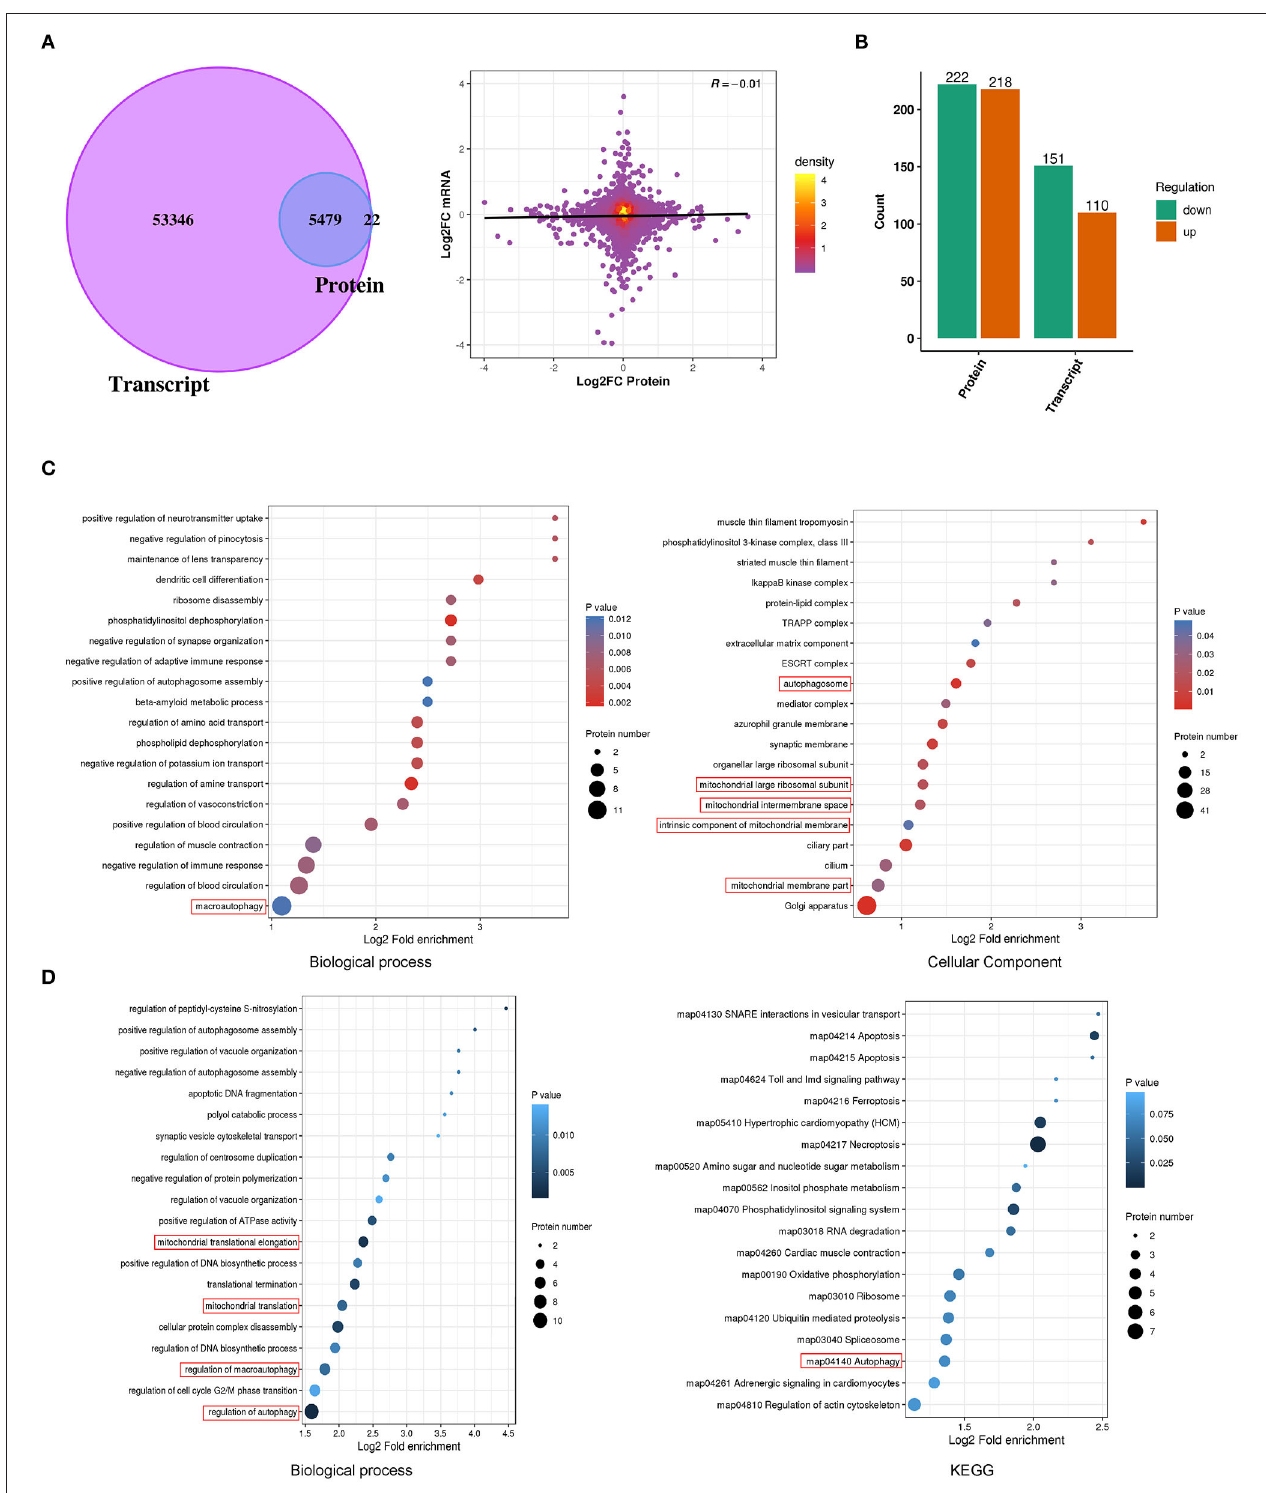
FIGURE 3 | Proteomic combined with transcriptomic analysis of E2-BSA treated Ishikawa cell line. (A) Venn diagram and volcano chart depicting the overlap of proteomic and transcriptomic relative genes. (B) The distribution of genes up- and down-regulated in protein and transcript, respectively. (C) Results of GO and KEGG analysis of the up-regulated genes in proteomic. (D) Results of up-regulated proteomic combined with unchanged transcriptomic genes of GO and KEGG analysis.